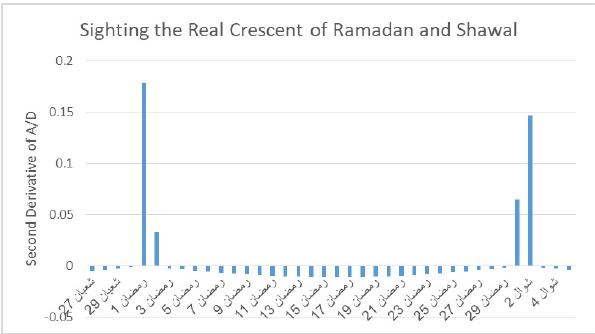
Figure 9. The Positive values of (A/D) \\ Represents The Exact Start of The